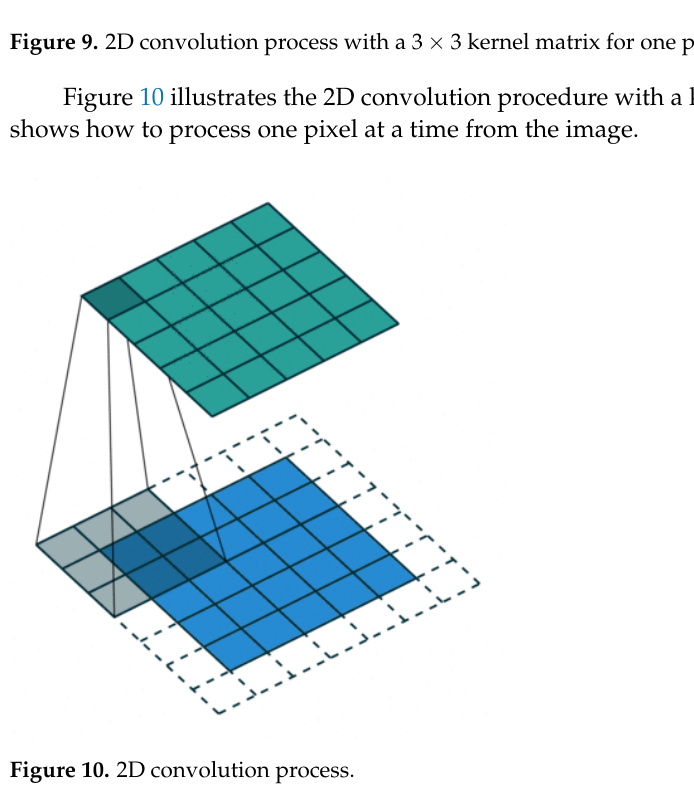
Figure 9. 2D convolution process with a 3